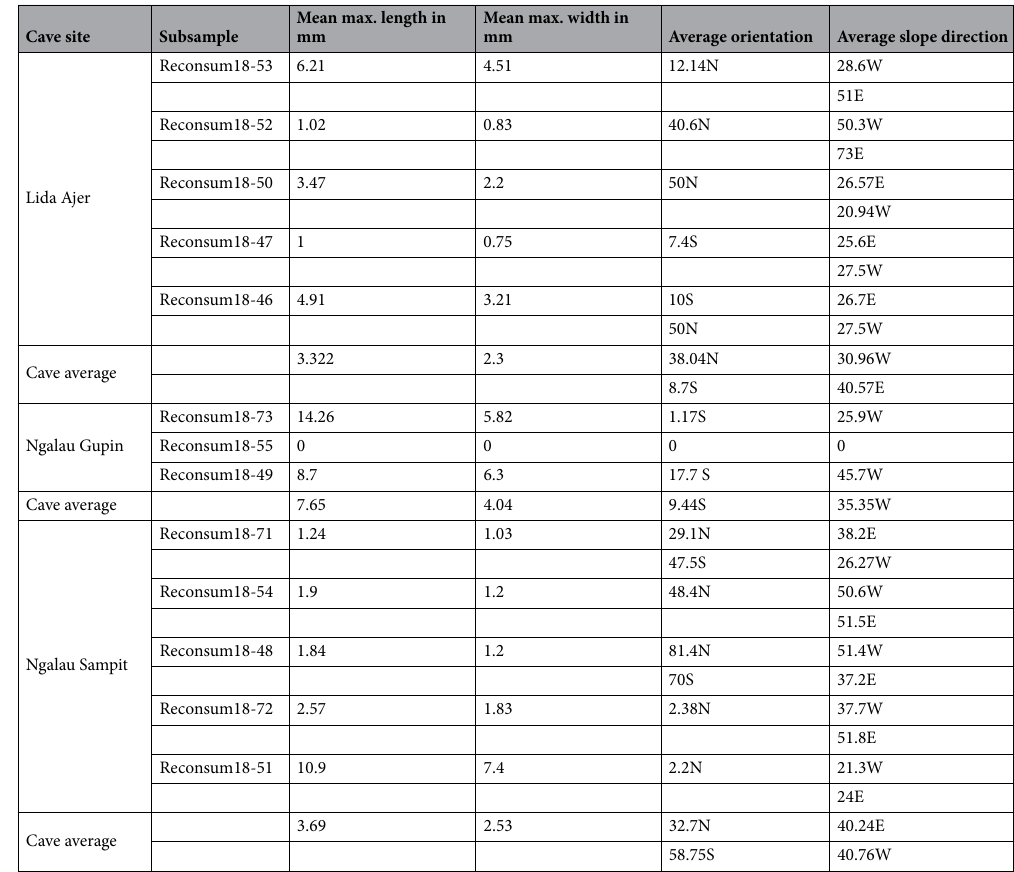
Table 3. The mean maximum length and width, and the slope and slope direction of the internal clasts of the thirteen discrete breccia subsamples. The average result for each individual cave is provided after each set of breccia subsamples. More than one average slope direction is given for subsamples in which clasts commonly slope in two or more cardinal directions.